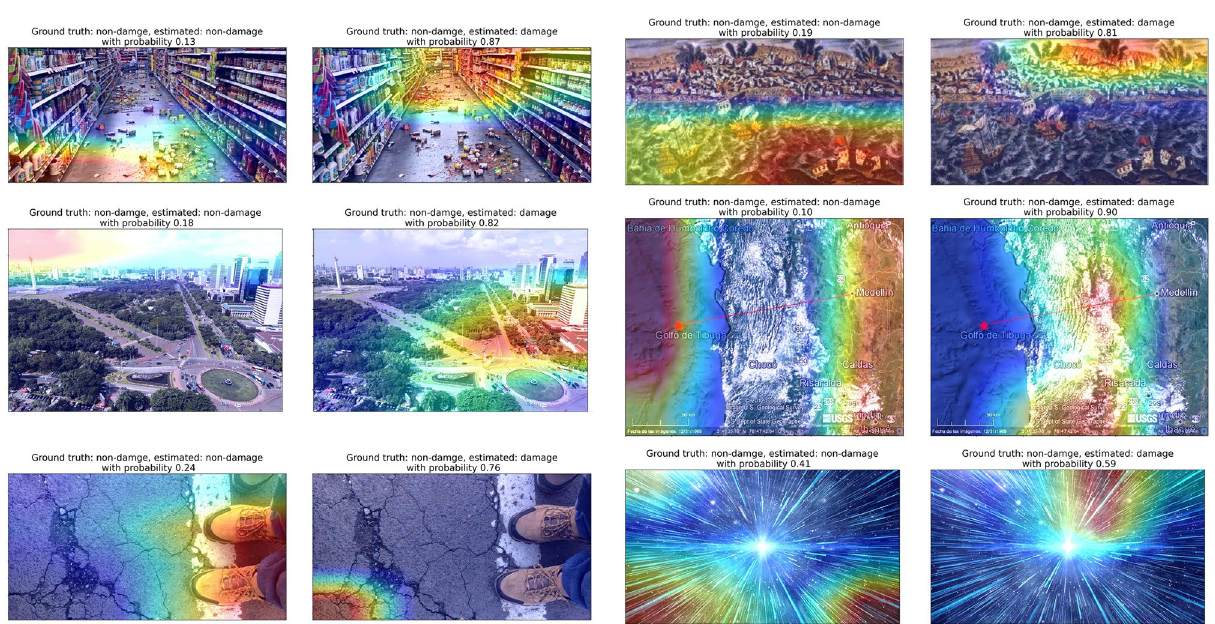
Figure 8. Grad-CAM heatmap on images that the model made the wrong decision for non-damage class (False Positives) . Heatmap overlaying images indicates where the model pays more attention when making the decision; warmer colors indicate stronger influence on the decision. Each image is shown twice and overlaid with a heatmap indicating the regions of the image that suggest building damage, and the regions that suggest no building damage. The ground truth, estimated label and estimated probability is shown in the title above each